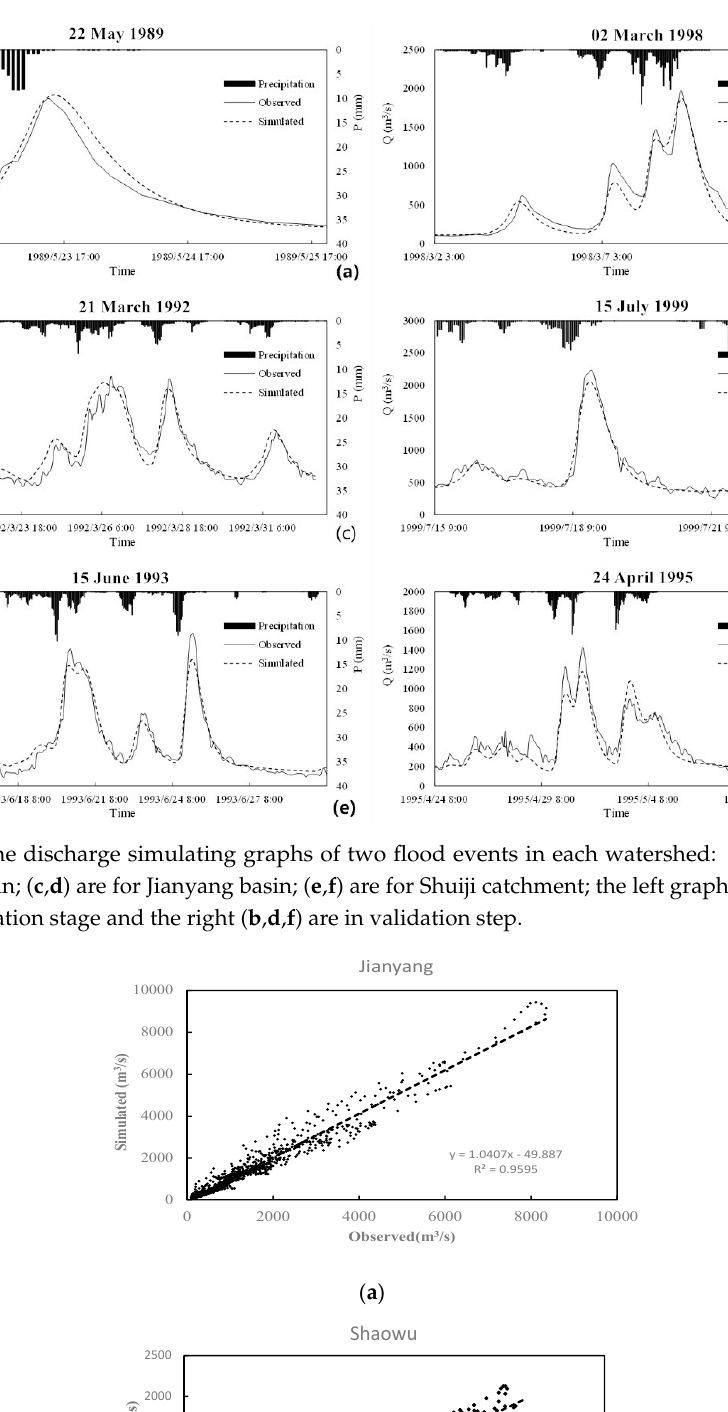
y = 0.9813x -25.036 R² = 0.9399